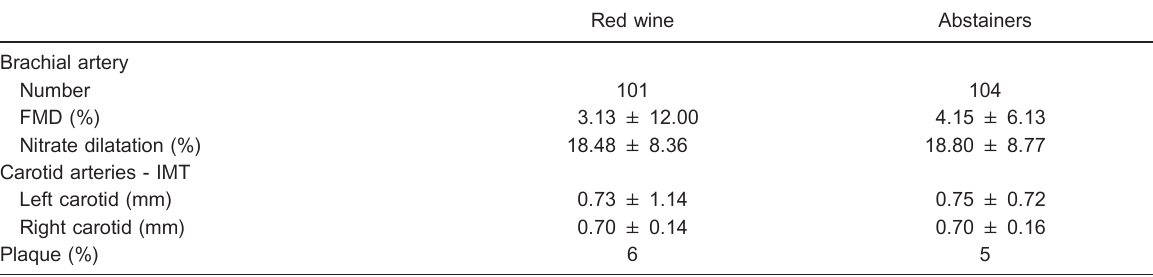
FMD: flow mediated dilatation; IMT: intima/media thickness. There were no significant differences between groups ( t -test for FMD and IMT; chi-square test for